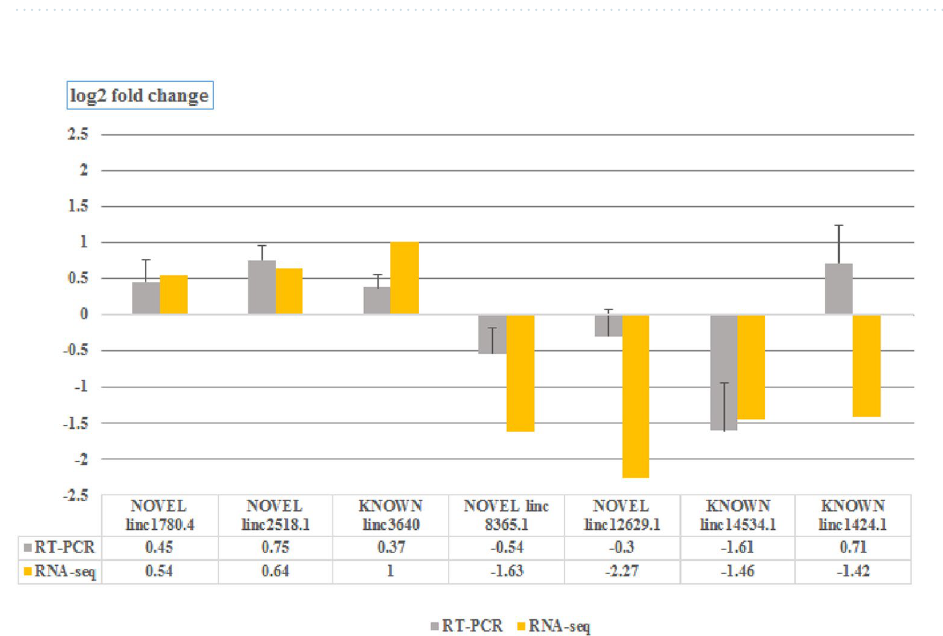
Figure 4. Validation of seven randomly selected novel lincRNAs by RT-qPCR. The fold change represents the ratio of average expression of native samples relative to that of commercial breed